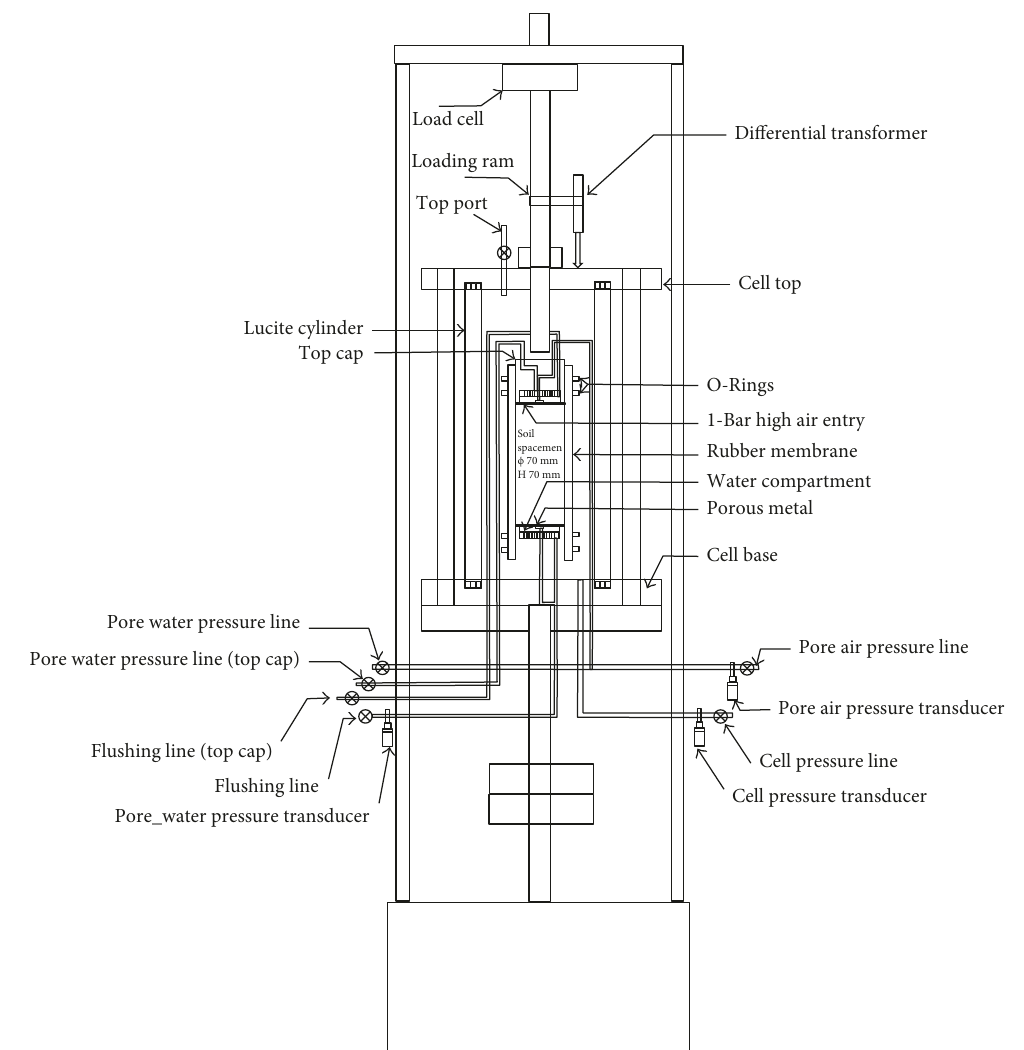
Figure 1: Schematic diagram of modified triaxial apparatus for permeability